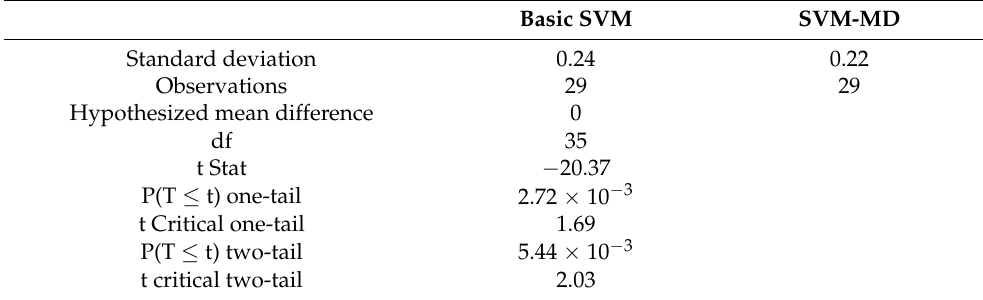
Table A5. t -Test: two-sample assuming unequal variances between basic SVM and SVM-MD, RC beam.